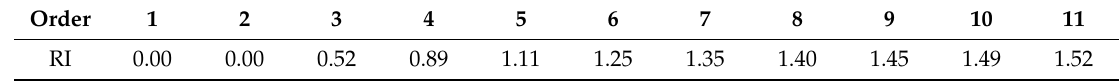
Table 5. Saaty’s ratio index for di ff erent values of n